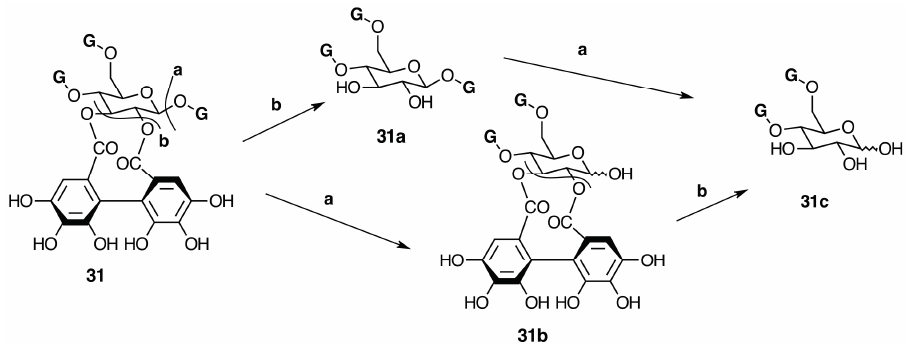
Figure 13. Degalloylation ( a ) and de-HHDP-ation ( b , c ) of pterocaryanin C ( 31 ).